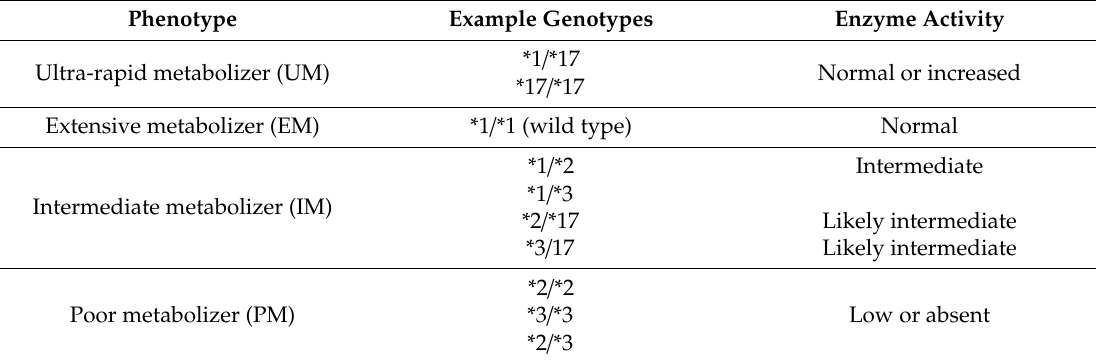
Table 3. Anticipated CYP2C19 phenotypes corresponding to genotypes. Used with permission